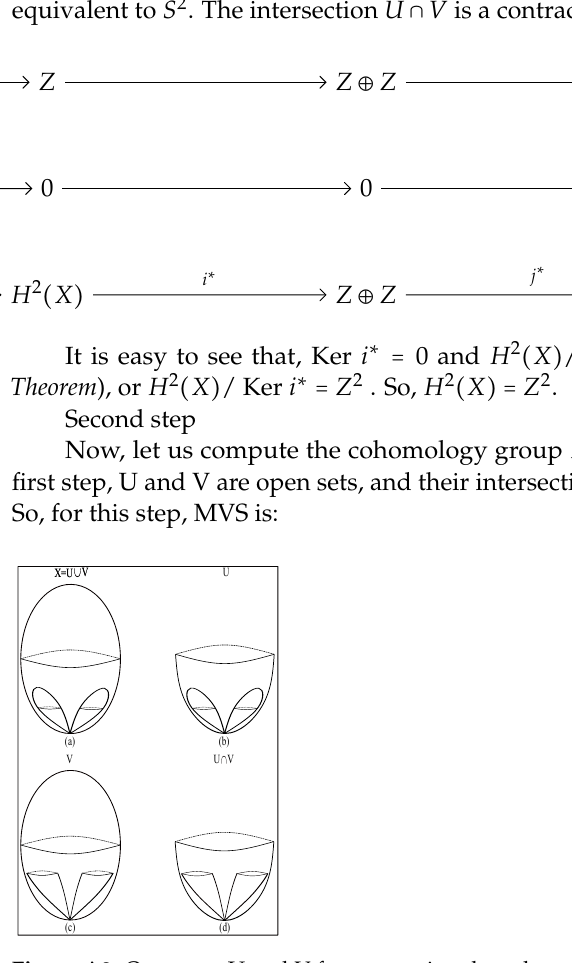
Figure A2. Open sets U and V for computing the cohomology group H 2 ( X )